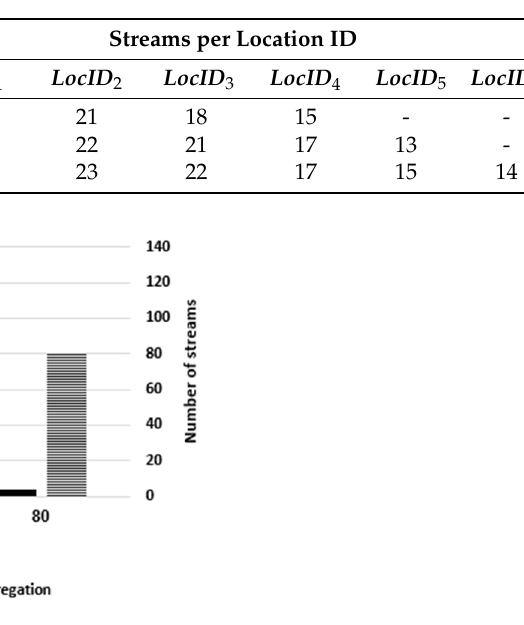
Figure 12. The number of aggregated streams vs. the sample size.